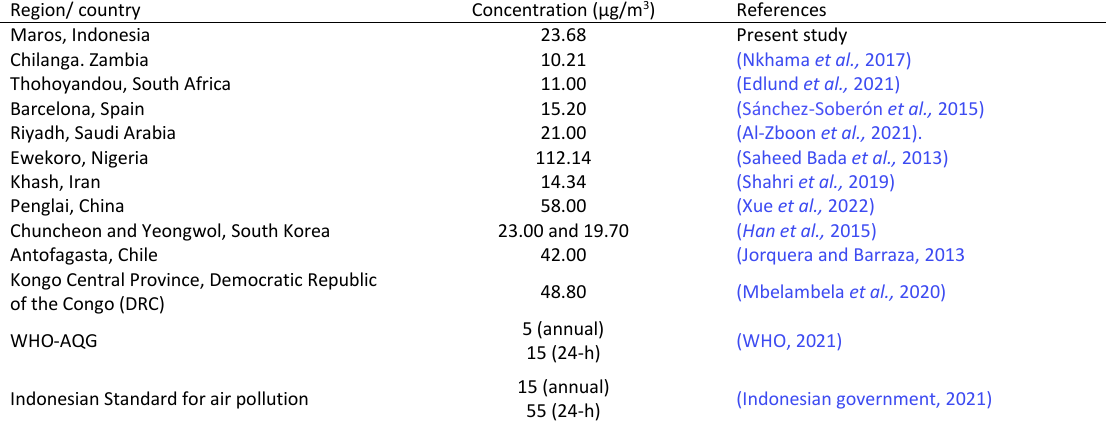
from Maros cement, other studies and air quality 2.5